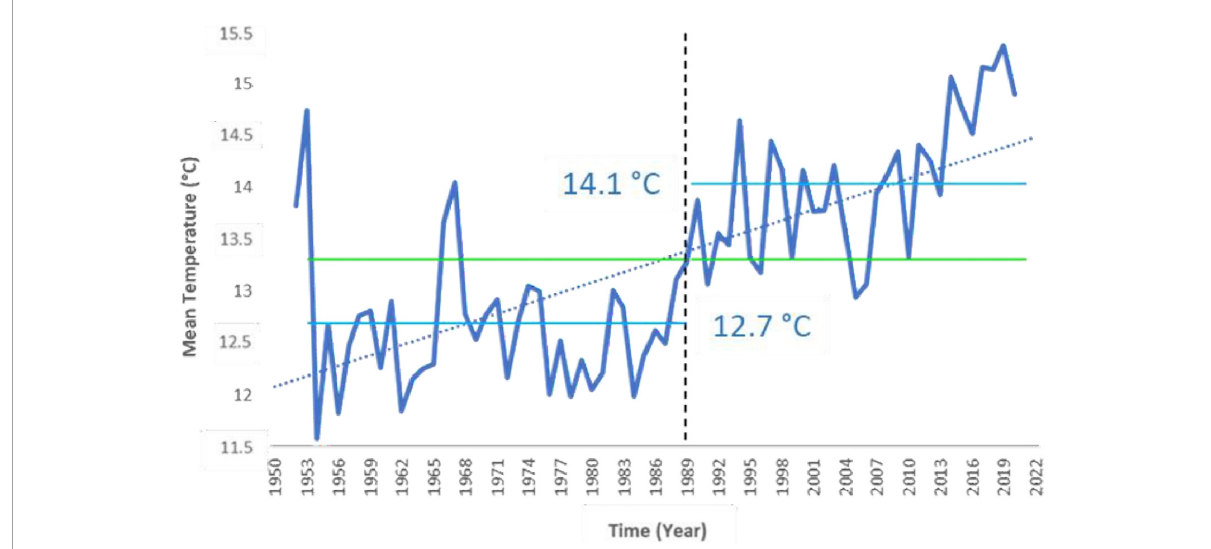
FIGURE1 University of Bologna agrometeorological station annual mean air temperature and its increasing trend (dashed blue line). The trend was significant with 95% confidence. A breakpoint in annual mean air temperature was found in 1989. The two labeled lines represent the average temperature for the periods before (T mean = 12.7 ◦ C) and after (T mean = 14.1 ◦ C) the breakpoint,